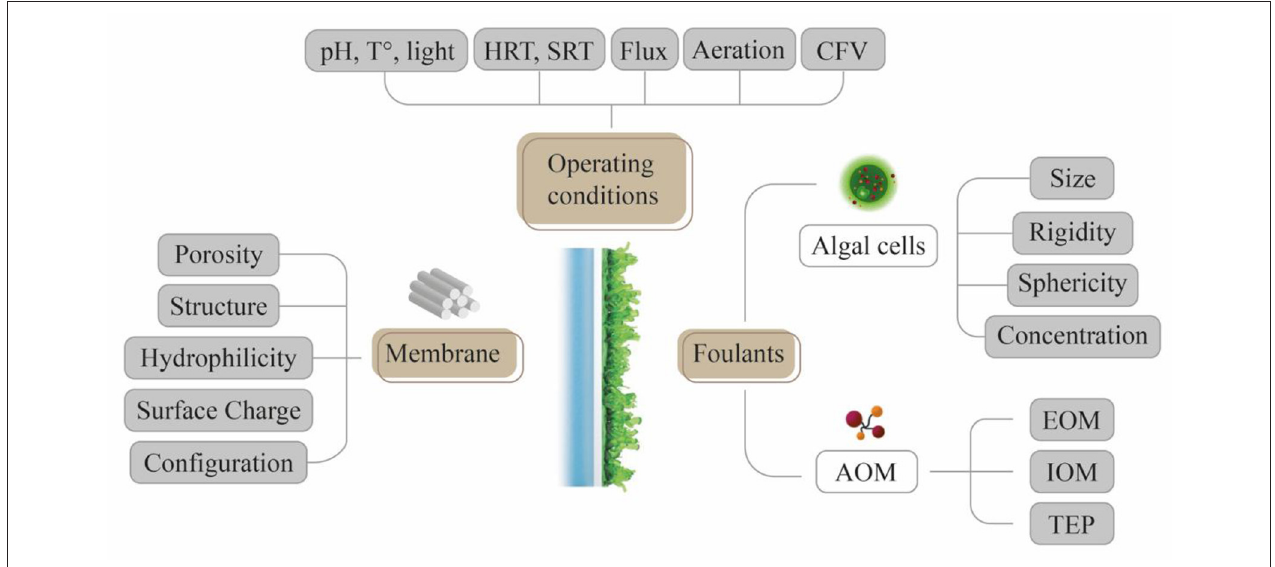
FIGURE 3 | Summary of fouling contributing factors in algal membrane separation processes. The membrane fouling is influenced by the operating conditions, the membrane, the algal species, and